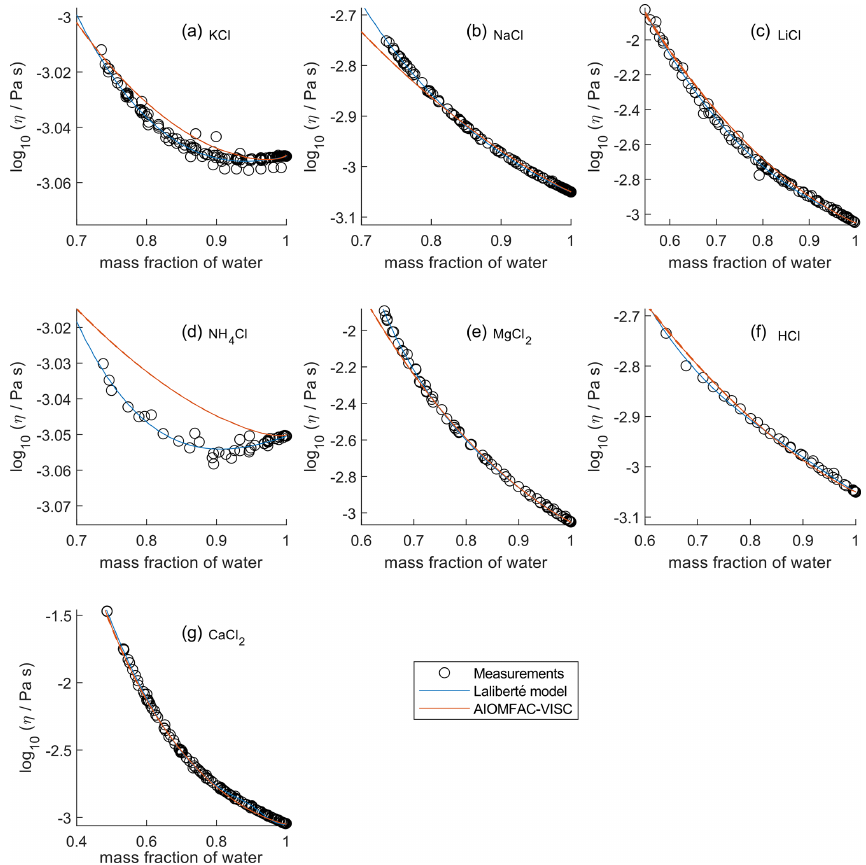
Figure 2. Comparison of closeness of fit for aqueous chloride salts/acids at 298K with bulk measurements shown for 298 ± 1K. Zooms are adjusted in each panel to best fit the measurement ranges. AIOMFAC-VISC model sensitivity, defined by a ± 2% change in aerosol water content, is shown by red dashed curves. See Fig. 4 for model extrapolations throughout the full concentration range and Table 2 for information on the measurement